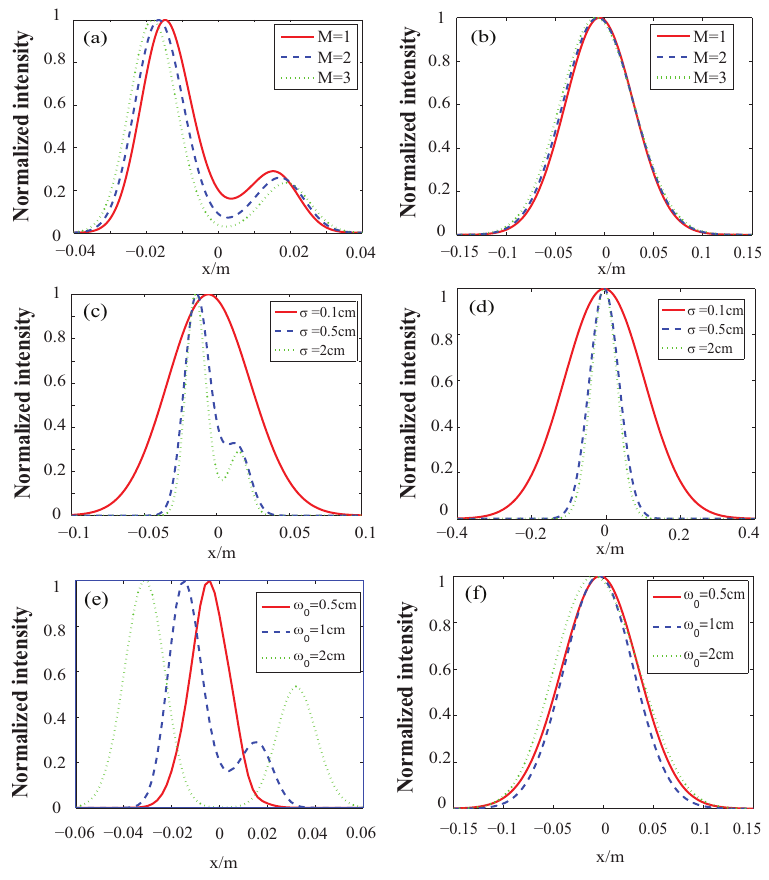
Figure 5. Cross lines ( y = 0) of the normalized average intensity of the OAHGSM vortex beam passing through anisotropic oceanic turbulence with different M , σ , and ω 0 at z = 300 m ( a ), z = 1200 m ( b ), z = 300 m ( c ), z = 1200 m ( d ), z = 300 m ( e ), and z = 1200 m ( f ).